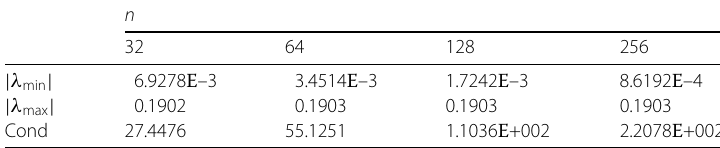
Table 3 The condition number with k = 1